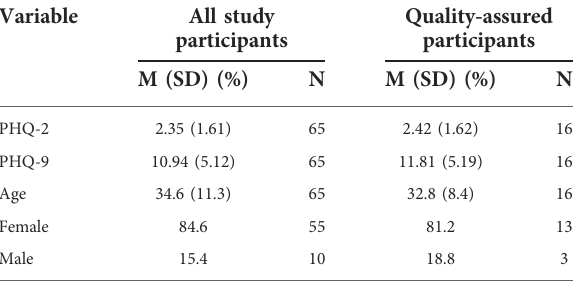
TABLE 2 Statistics of the MAIKI dataset. For PHQ-2, PHQ-9 and the age of the participants, we report the (M)ean value as well as the (S) tandard